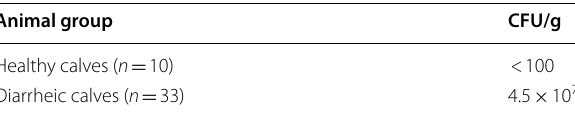
Table 6 Pathogenic E. coli bacterial count of fecal samples from healthy and diarrheic bovine calves Animal group CFU/g Healthy calves ( n 10) < 100 = Diarrheic calves ( n =